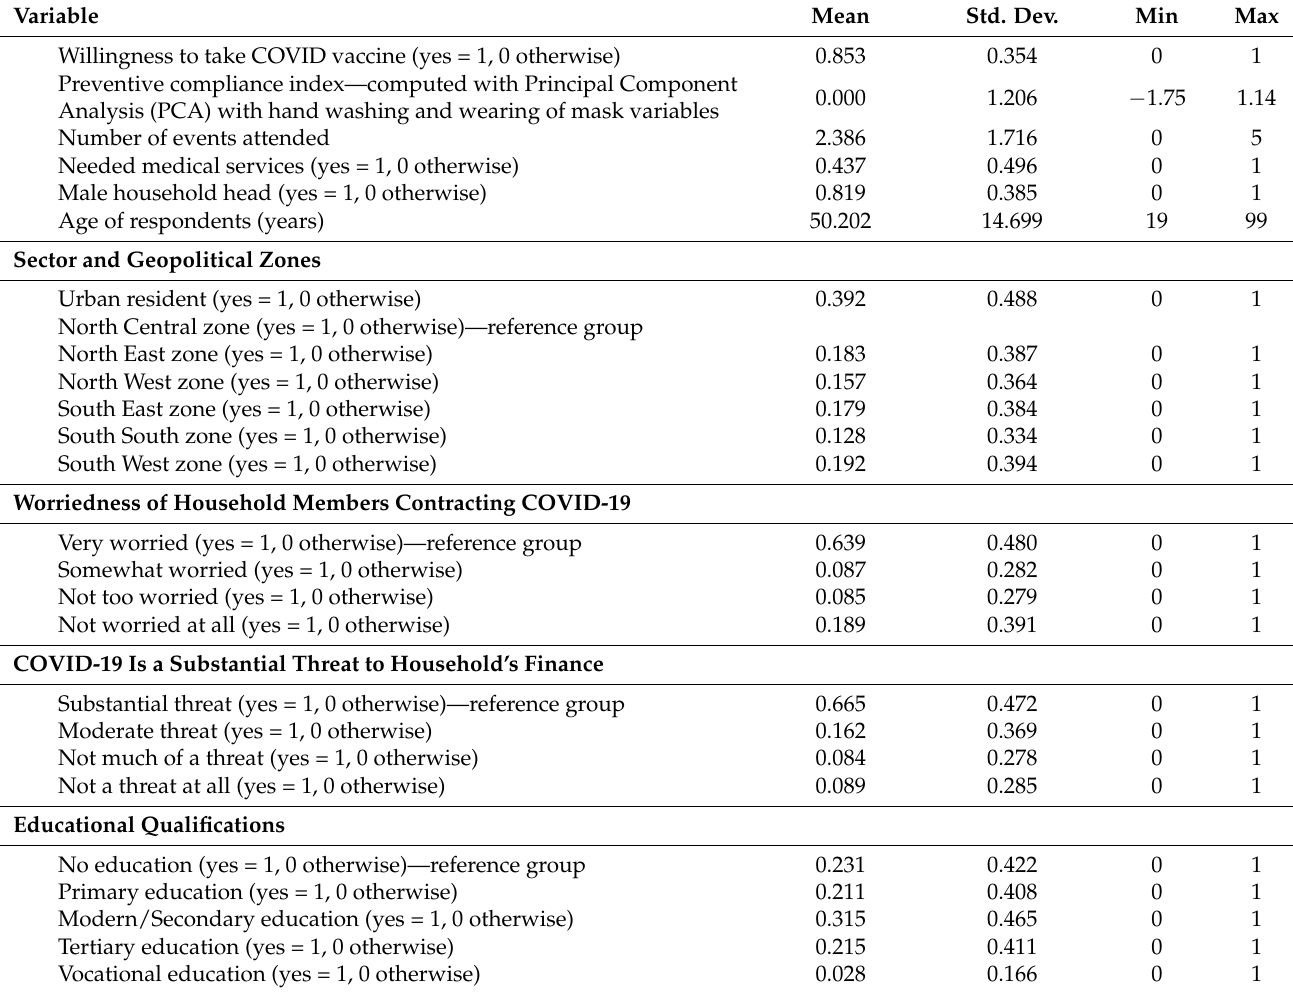
Table 1. Coding of Selected Variables for Logit Regression